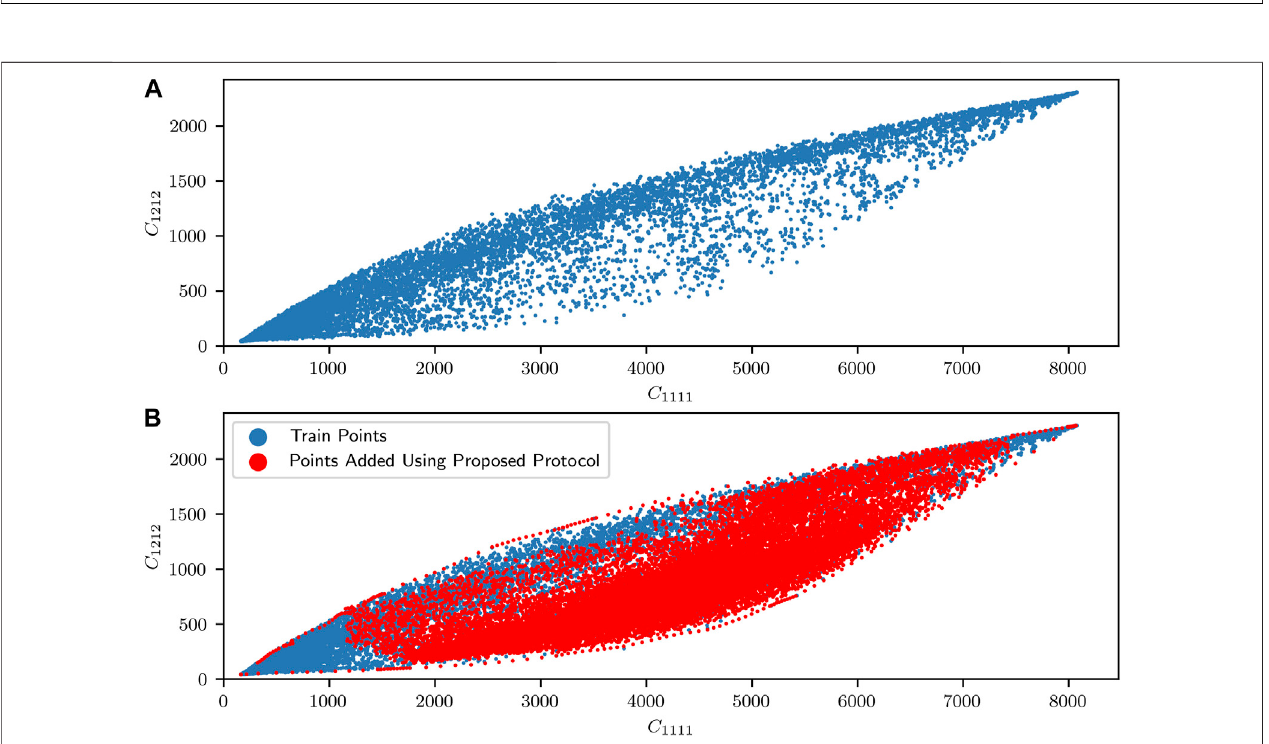
FIGURE 6 | (A) Original estimate of the property closure produced using the dataset generated to initially train the CNN surrogate model. (B) Updated property closure using the protocol presented in Section 3.2 . The red points represent the new points generated in the process of building the property closure.